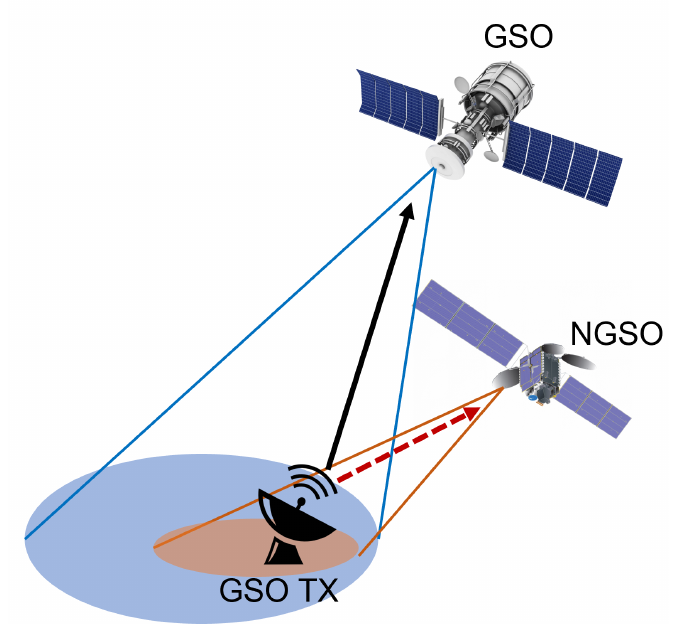
Figure 2. Example of an onboard interference scenario between NGSO and